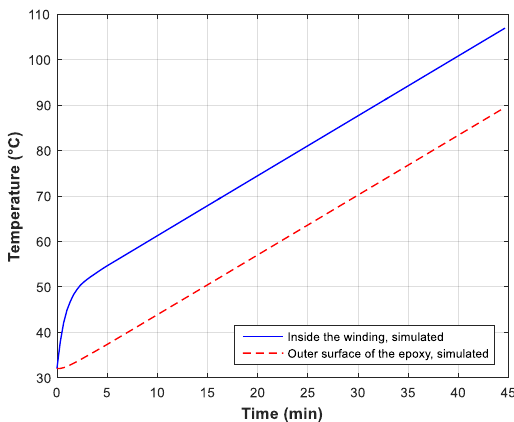
Figure 20. The geometry used in the numerical model used for validation.